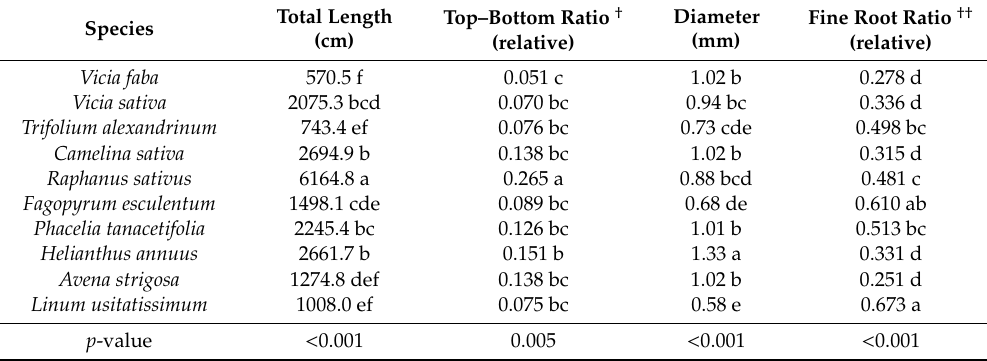
Table 1. Morphological characteristics obtained from visible roots at the surface of rhizoboxes.